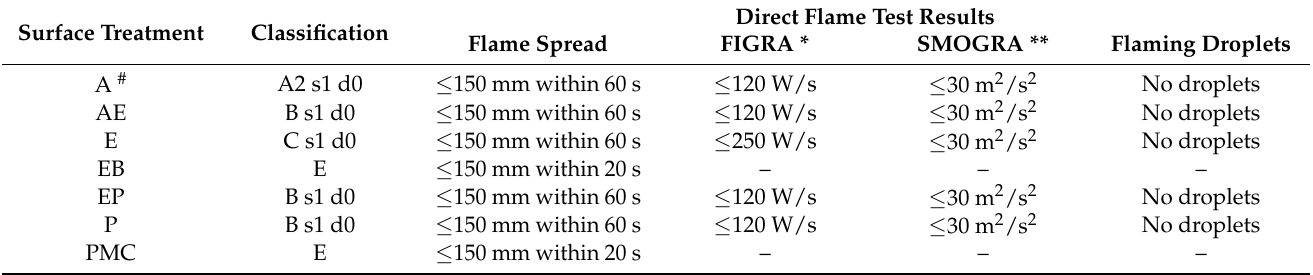
Table 7. Fire resistance of coatings (main results).